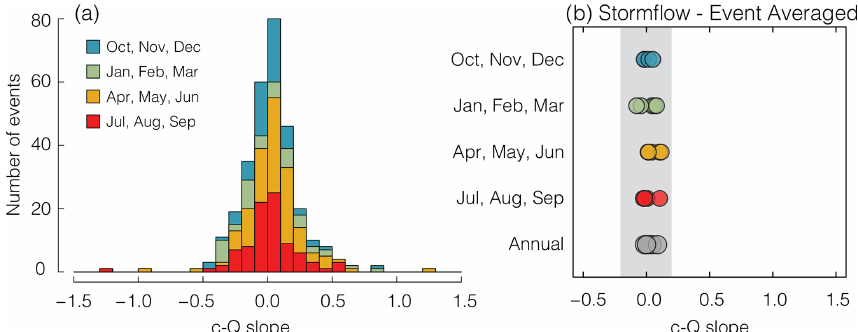
Figure 5. (a) Individual storm event c – Q slopes for all five watersheds colored by season, and (b) event-averaged stormflow c – Q slope by season calculated individually for each watershed. Gray boxes indicate chemostatic behavior ( | c – Q slope | ≤ 0 . 2).